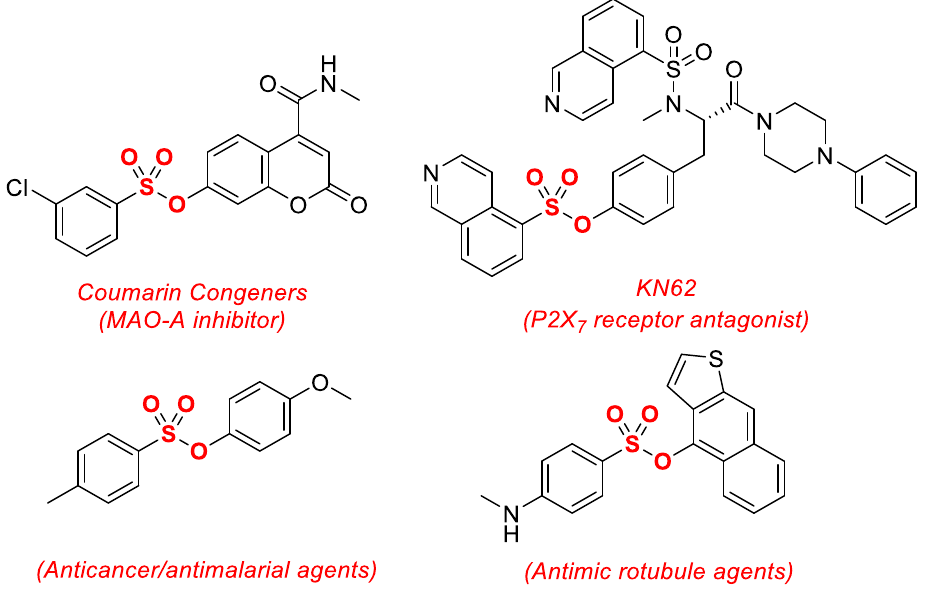
Figure 1. Representative bioactive compounds and pharmaceuticals containing sulfonate ester group.